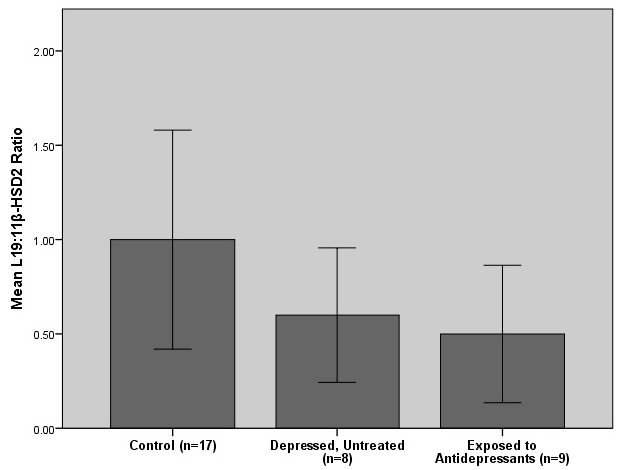
Figure 2. Comparisons of placental HSD11B2 expression levels between the control, depressed (untreated) and antidepressant exposed groups. Histogram shows mean values +/ − standard error of the mean.